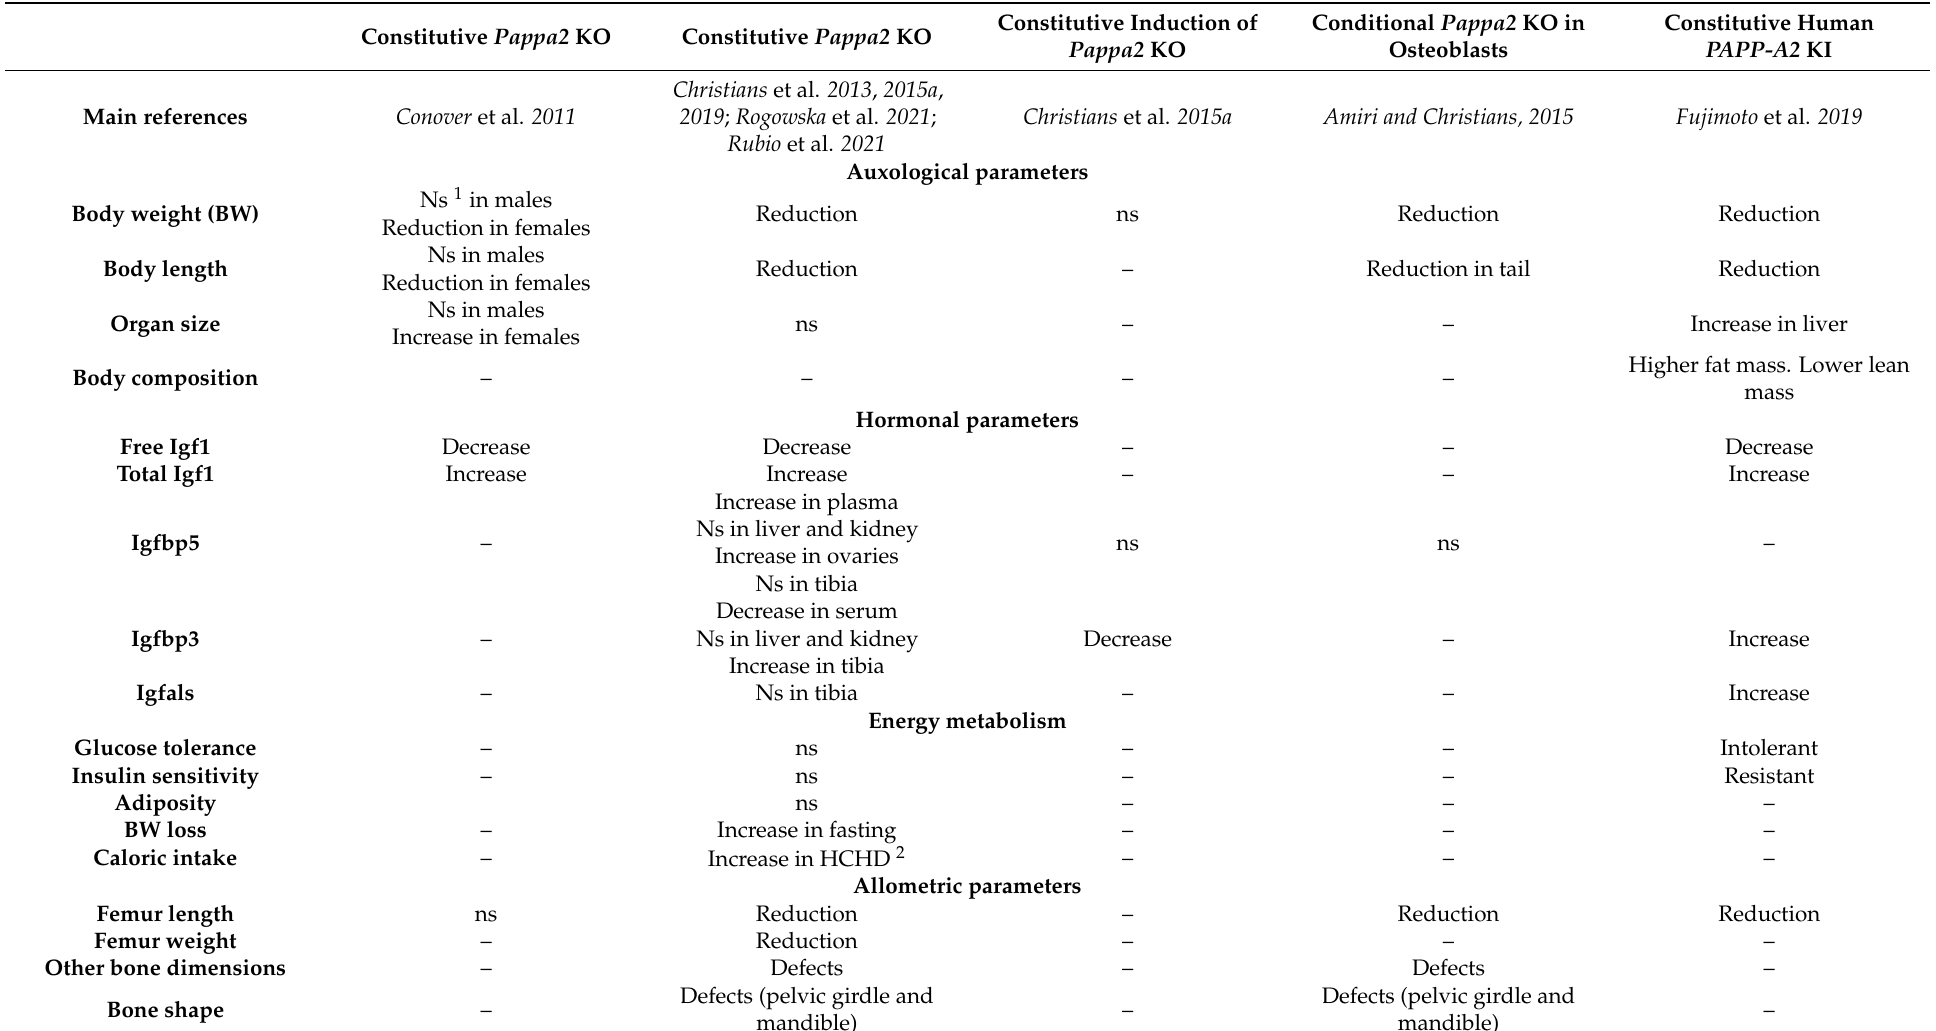
Table 1. Summary of the main effects of Pappa2 deficiency on auxological, hormonal, metabolic and bone mineral